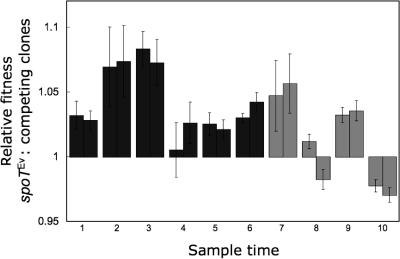
Fitness of Clones Containing a spoT
Ev Beneficial Allele in Rec+ and Rec− High Mutation Rate Lines Relative to Five Contemporary Clones Not Containing This AlleleThe number labels for competing spoT
Ev clones follow the sampling numbers indicated in Figure 2. Each bar represents one of two spoT
Ev clones isolated at each sample point. dark gray bars indicate rec+ lines; light gray bars indicate rec− lines. Error bars are standard error of the mean.